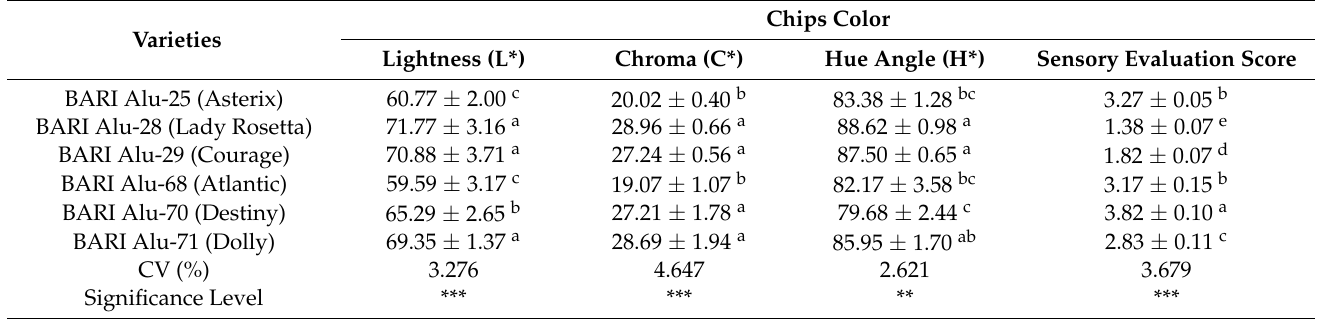
Table 4. Chip color (lightness, chroma, hue angle, and sensory evaluation) of different processing potato